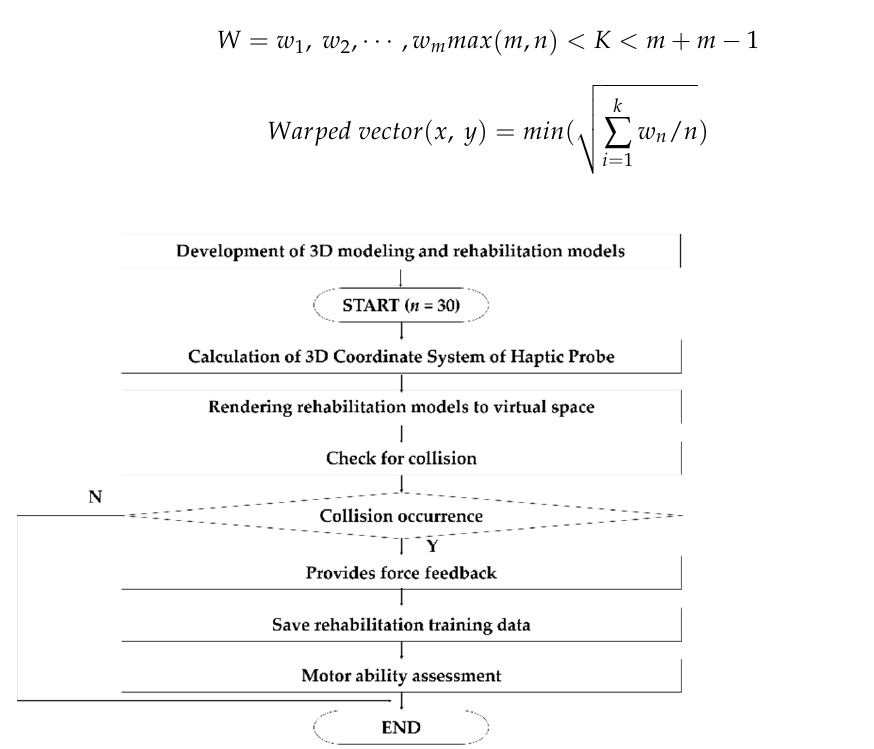
Figure 3. Design scheme of the proess to assess motor ability by providing force feedback and storing collision data within the model during rehabilitation in real